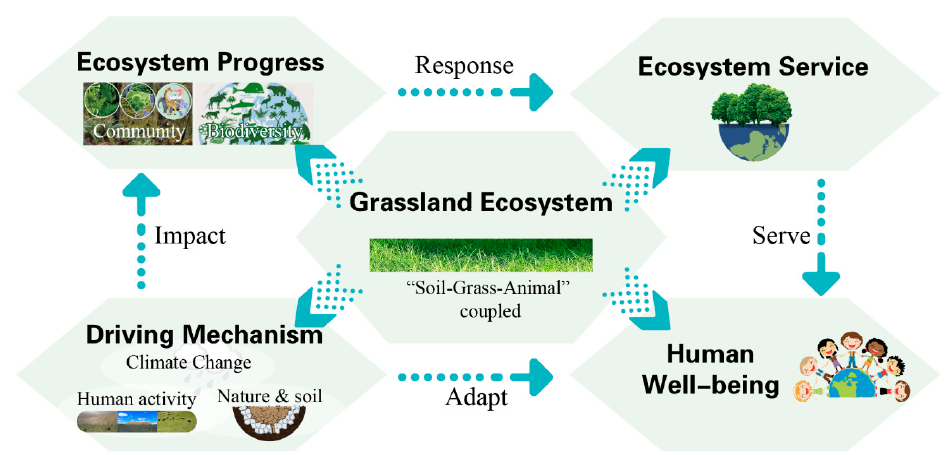
Figure 8. Thematic map of a grassland ecosystem.